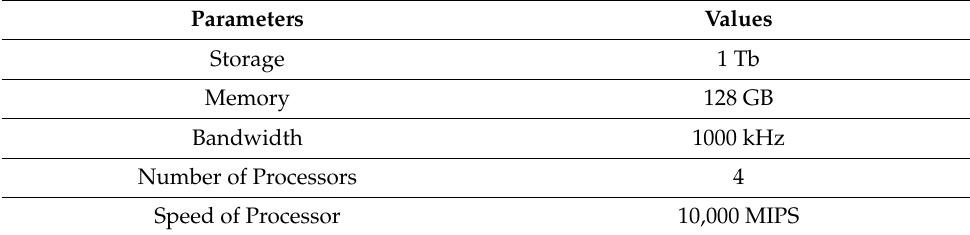
Table 4. PM Characteristics.